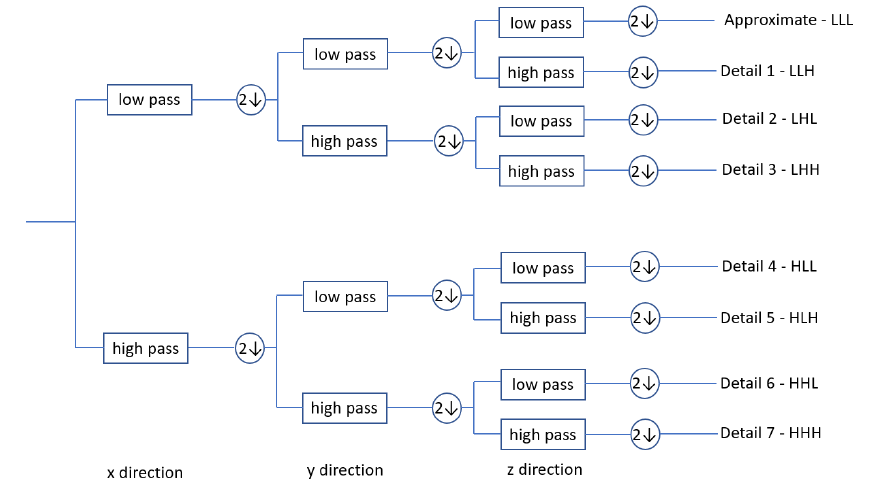
Figure 4. Illustration of the 3D